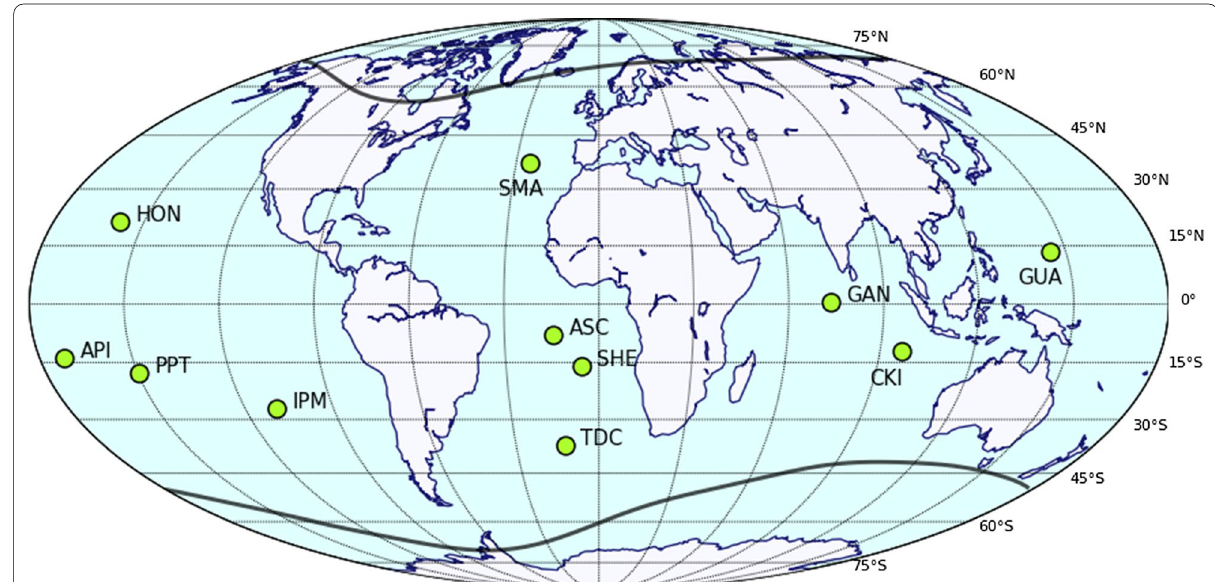
Fig. 1 Location of geomagnetic observatories used in this study (green dots). Black lines depict ± 55 ◦ quasi-dipole latitudes. Relevant